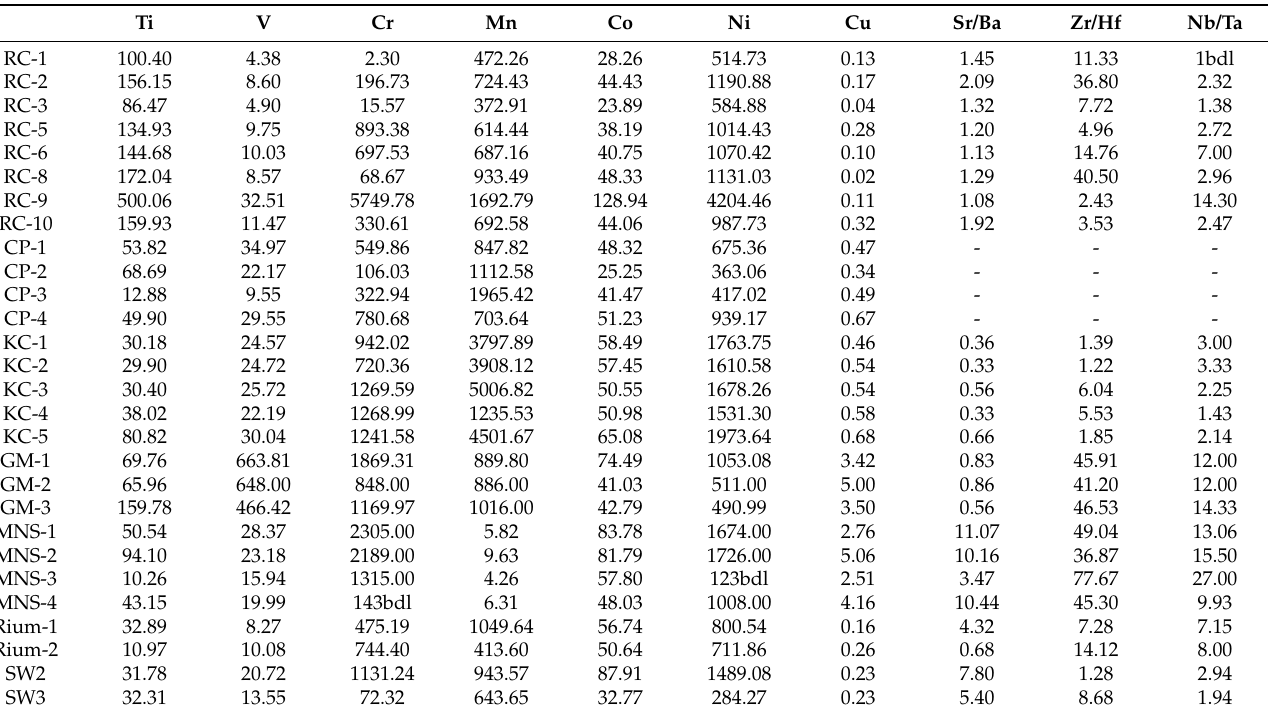
Table A2. Some trace elements of samples of green nephrite from different deposits